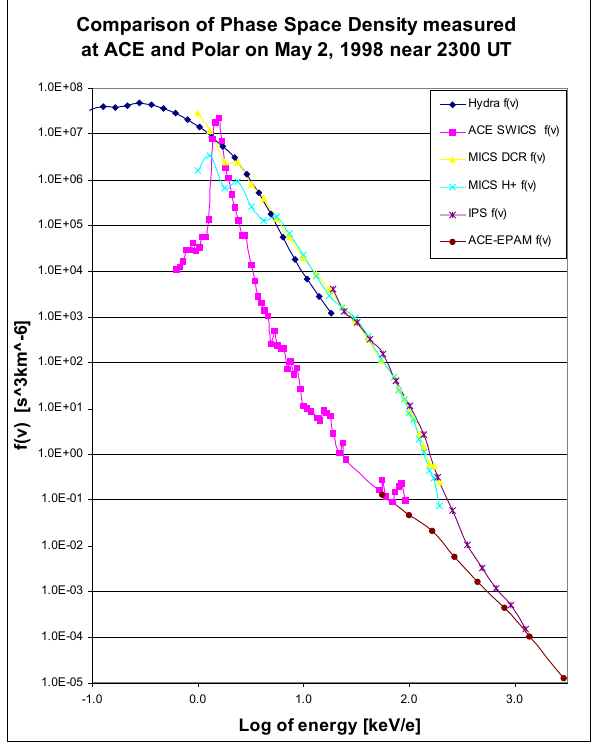
Fig. 3. Same format as Fig. 2 but now the two populations corre- spond to a plasma with an average Fe charge state of +10 recorded just before 23:00UT on 2 May at ACE and just after 23:00UT at